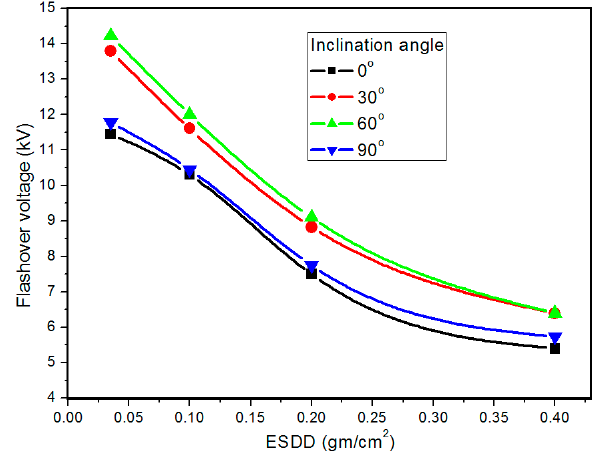
Figure 19. Flashover voltage at different inclination angles, where pollution distribution = uniform, NSDD = 0.75 mg/cm 2 , humidity level = low, temperature = 10 °C, and standard deviation = 2.1%–6.8%.